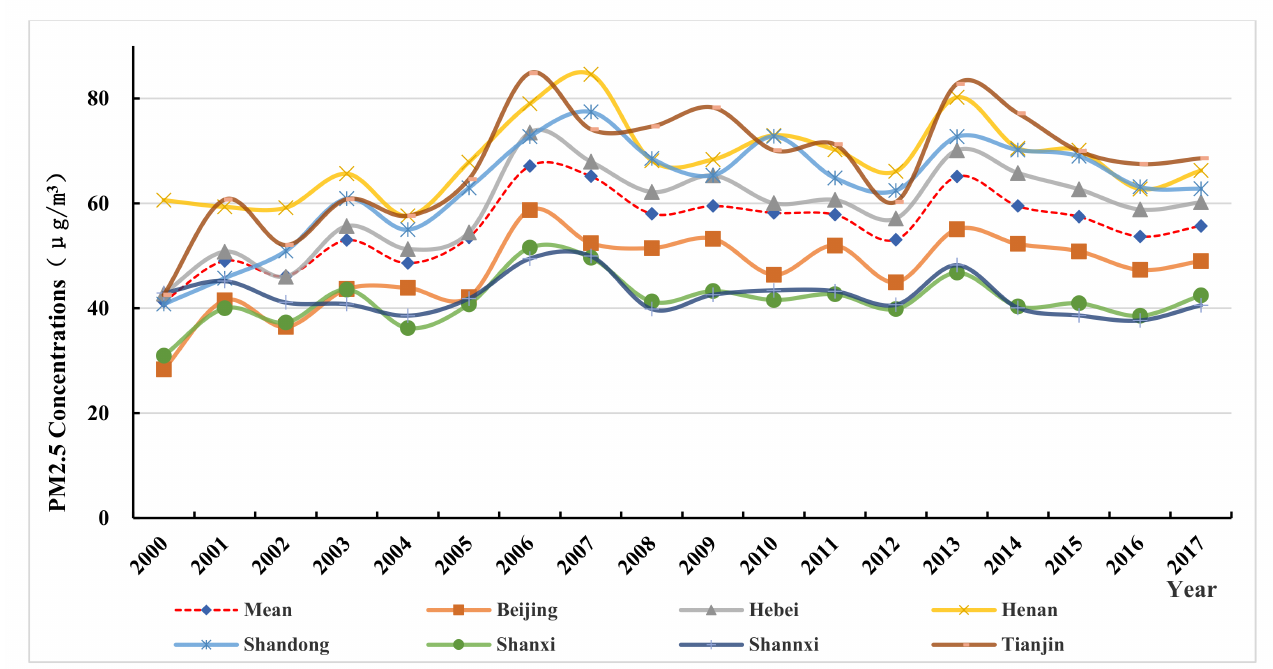
Figure 5. Temporal variation in annual average PM 2.5 in different provinces and